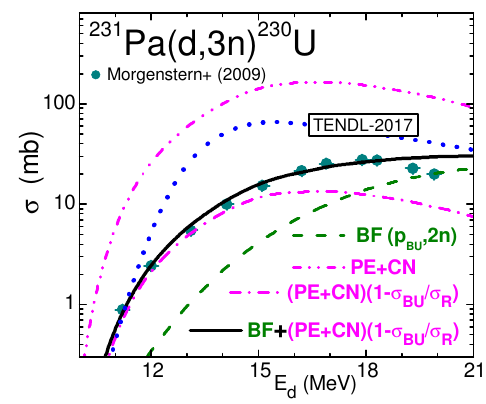
Figure 1. Comparison of the measured [7], latest TENDL- 2017 [11] evaluation (dotted curve) and model calculation (solid curve) including the BF (dashed curve), and PE + CN contribu- tion to 231 Pa( d , 3 n ) 230 U reaction cross sections calculated with- out (dash-dot-dotted) and with (dot-dashed) inclusion of the BU e ff ect on σ R